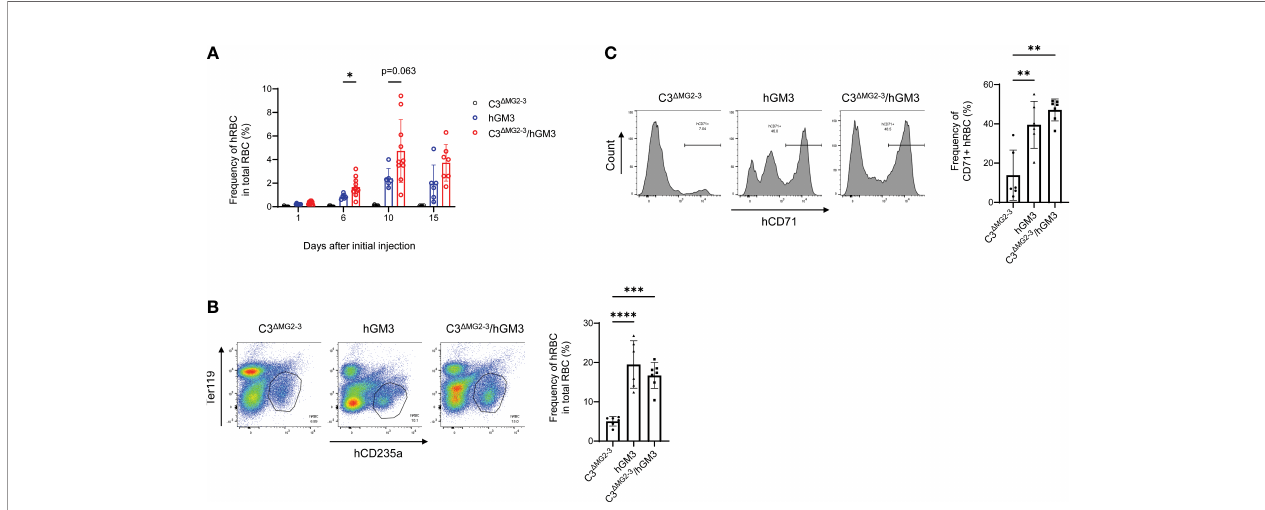
FIGURE 7 | Induction of hRBCs from hHSCs in NOG-C3 D MG2-3 /hGM3 Tg mice. (A) Development of hRBCs in hHSC engrafted mice. hHSC-NOG-C3 D MG2-3 /hGM3 Tg (n=13), hHSC-NOG-C3 D MG2-3 (n=15), or hHSC-NOG/hGM3 Tg (n=10) mice were treated with Clo-lip 8 weeks after HSC transplantation. PB was collected at the indicated time points and analyzed using fl ow cytometry. Note that six, nine and four in the hHSC-NOG-C3 D MG2-3 /hGM3 Tg, hHSC-NOG-C3 D MG2-3 , or hHSC-NOG/ hGM3 Tg died during the experiments. Asterisks indicate statistically signi fi cant differences between hHSC-NOG-C3 D MG2-3 and hHSC-NOG/hGM3 Tg mice as determined using Mixed-effects analysis (****p < 0.0001, **p < 0.01, and *p < 0.05). (B, C) Analysis of BM. BM cells from mice in (A) were collected 15 days after the initial Clo-lip treatment and stained with anti-hCD235a and anti-hCD71 antibodies. Representative FACS plots are shown with the frequency of human CD235a + cells in total RBC (B) . The frequencies of CD71 + immature hRBC in human CD235a + hRBCs are shown with the representative FACS histograms (C)